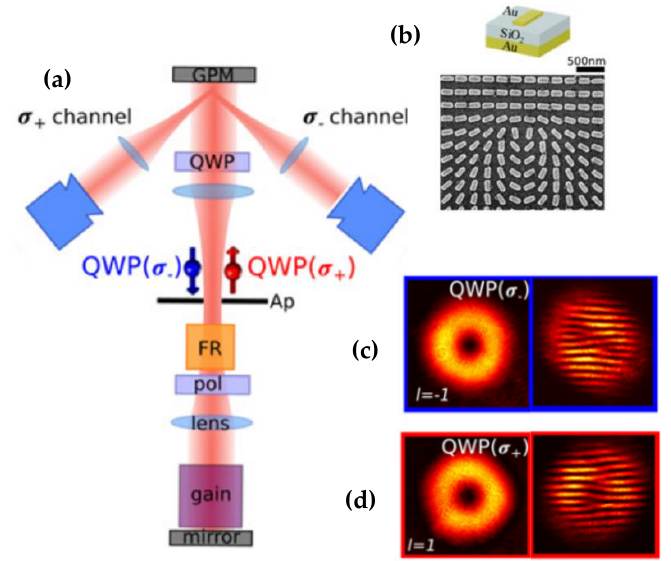
Figure 17. ( a ) Experimental setup of the degenerate laser using ( b ) a metasurface. ( c ), ( d ) Measured OAM output and self interference pattern at different channels. (Adapted from an open-access source Ref. [109]).